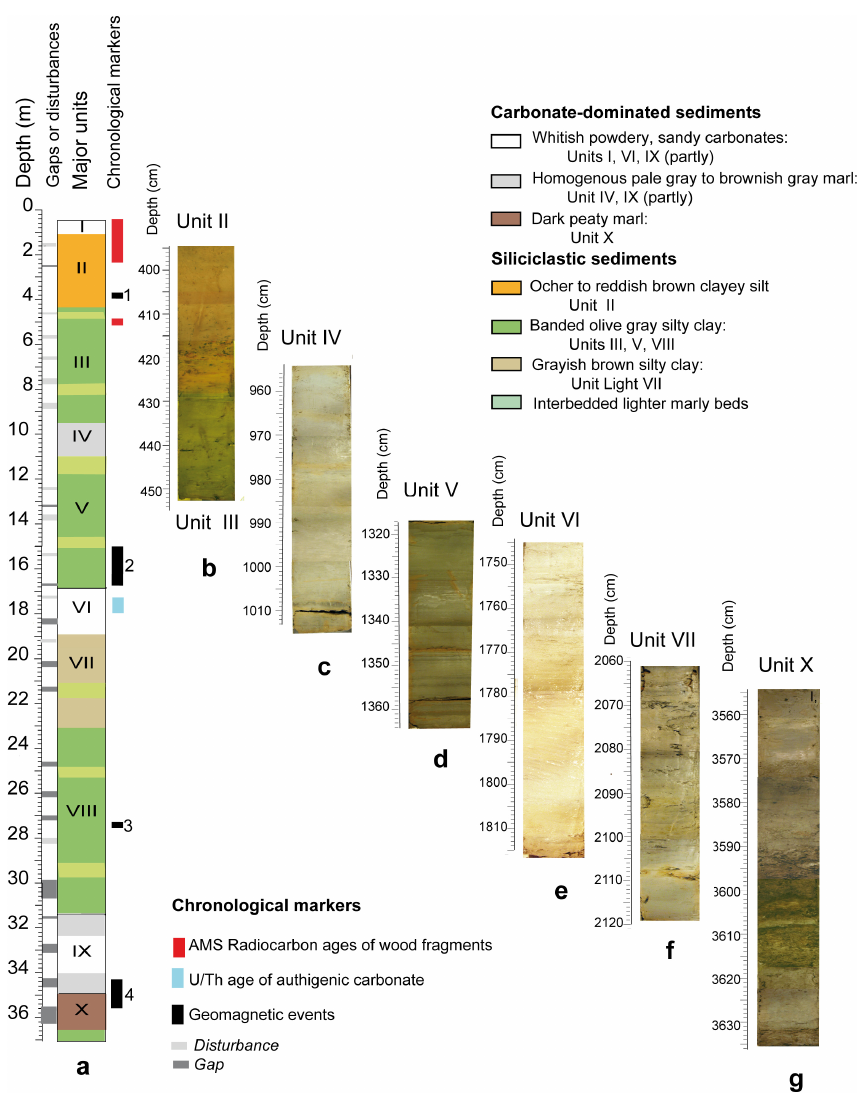
Fig. 4. Stratigraphy and lithofacies of the upper 36m of core Yam 04 C’. (a) Simplified stratigraphic log. Position of gaps in core recovery and of sediment disturbances on the left; position of chronological markers on the right. (b) to (g) Pictures of some core sections illustrating the facies diversity. (b) Transition from reddish, oxidized silt of Unit II to olive gray silty clay of Unit III. (c) Pale greenish marl. (d) Typical banded greenish marl. (e) Typical interglacial calcitic powdery deposits. (f) Brownish, coarsely banded silty clay. (g) Peaty marl of Unit